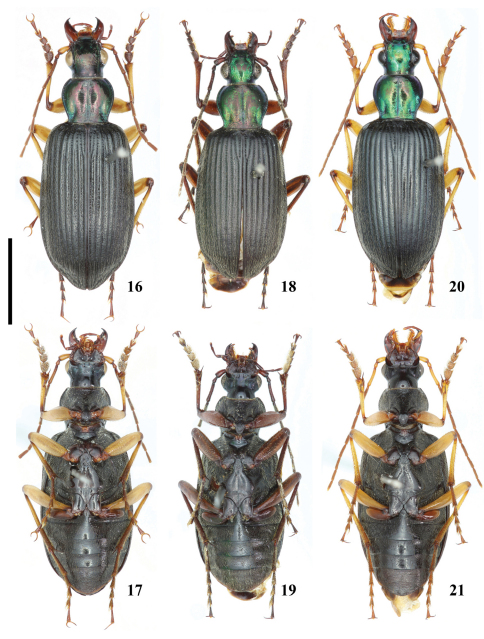
Habitus of Chlaenius (Lithochlaenius) spp16 Chlaenius chuanqianensis sp. n., holotype, male, dorsal view17 Chlaenius chuanqianensis sp. n., holotype, male, ventral view18 Chlaenius linwensini sp. n., holotype, male, dorsal view19 Chlaenius linwensini sp.n., holotype, male, ventral view20 Chlaenius propeagilis sp. n., holotype, male, dorsal view21 Chlaenius propeagilis sp. n., holotype, male, ventral view. Scale line = 5.0 mm.